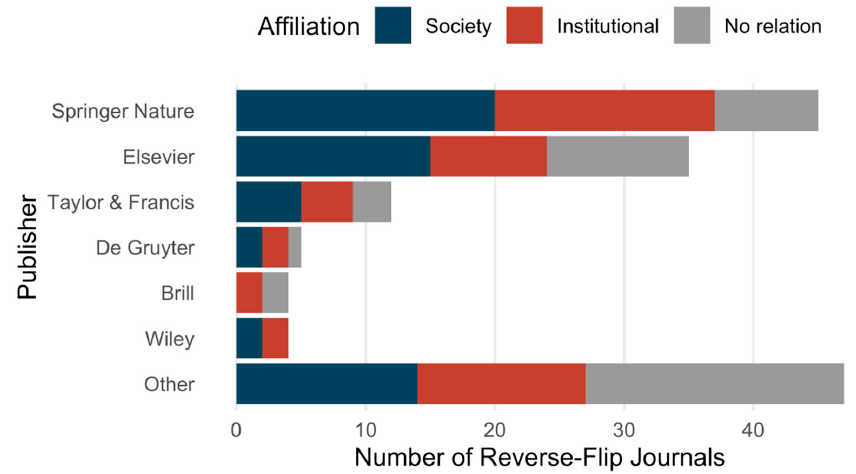
Figure 7. Reverse-flip journals’ affiliations with scholarly societies or research institutions, grouped by publisher.